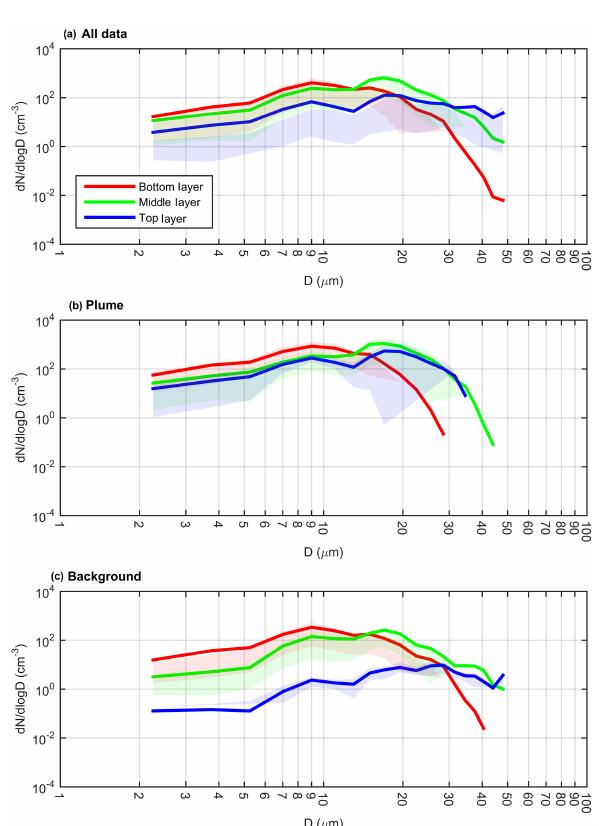
Figure 8. Averaged DSDs for three different cloud layers: bottom, middle, and top of the warm layer. Graph (a) shows the results for all DSDs irrespective of classification, while (b) is for polluted DSDs only, and (c) for background. Lines represent averages, while the shaded areas represent the dispersion between the 25 and 75%